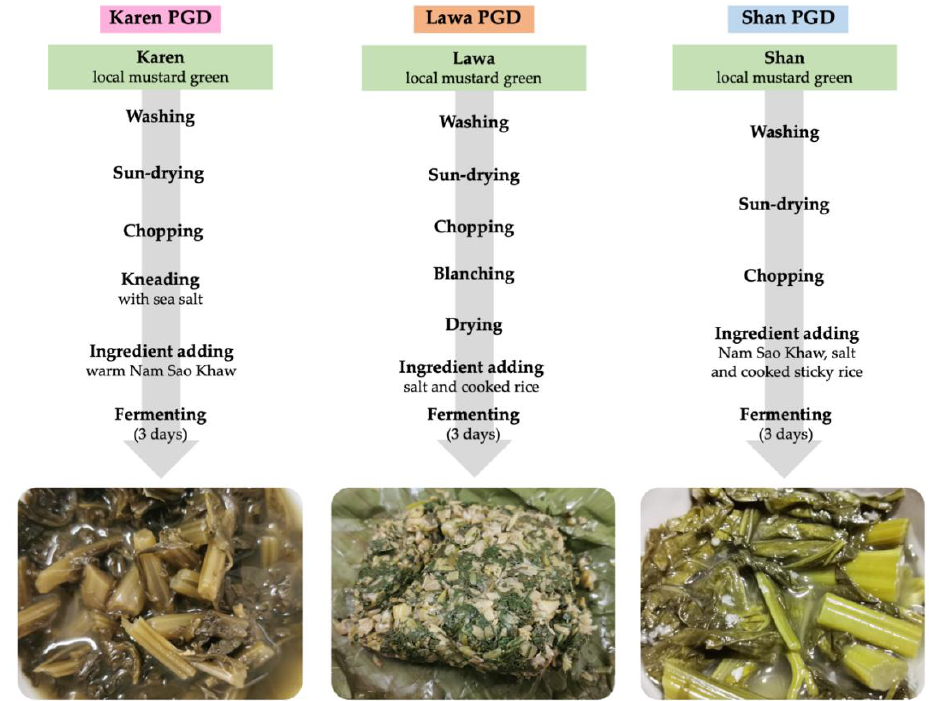
Figure 1. The PGD fermentation processes of the Karen, Shan, and Lawa, and characteristics of each ethnic PGD.